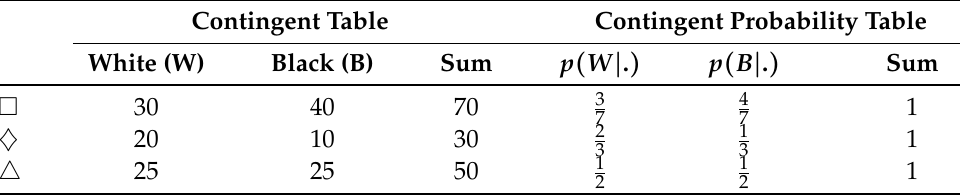
Table 2. Co-occurrence and conditional probability between Color and Shape.